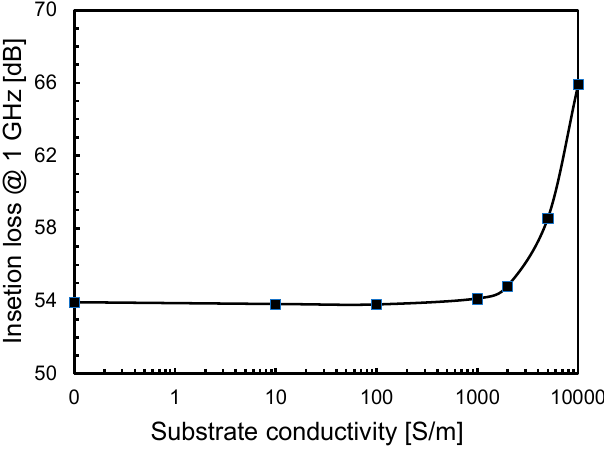
Figure 7. Antenna coupling insertion loss at 1 GHz as a function of the substrate conductivity, σ S , for a distance through insulation (DTI) of 500 µm (i.e., antenna distance of 730 µm).